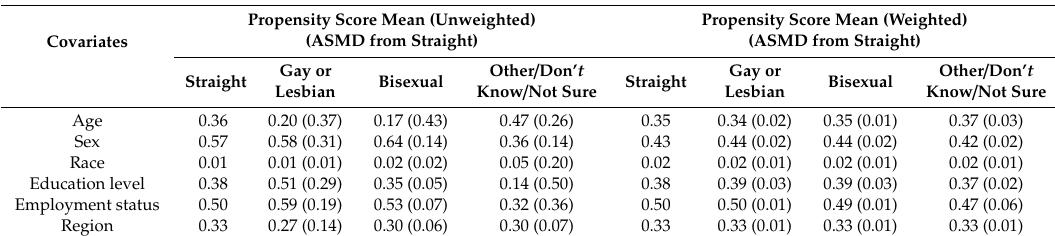
Table 2. Pre- and post-propensity weighted means for covariates and absolute standardized mean difference (ASMD).